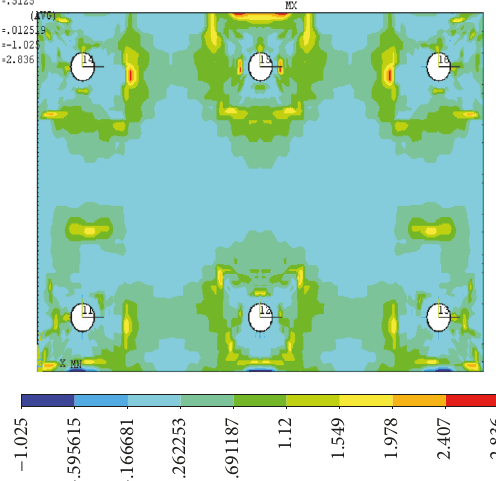
Figure 3: Principal tensile stress when the displacement resulting from the corrosion-induced expansion reaches 0.0025 mm.